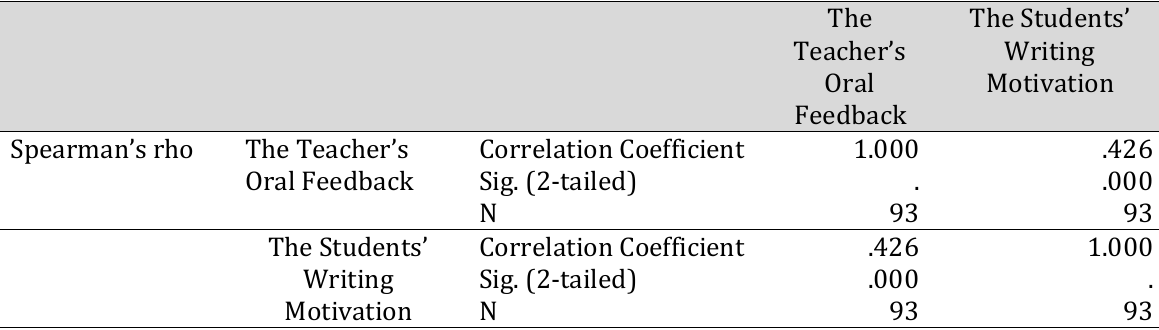
Table 14. the results of rank spearman correlation